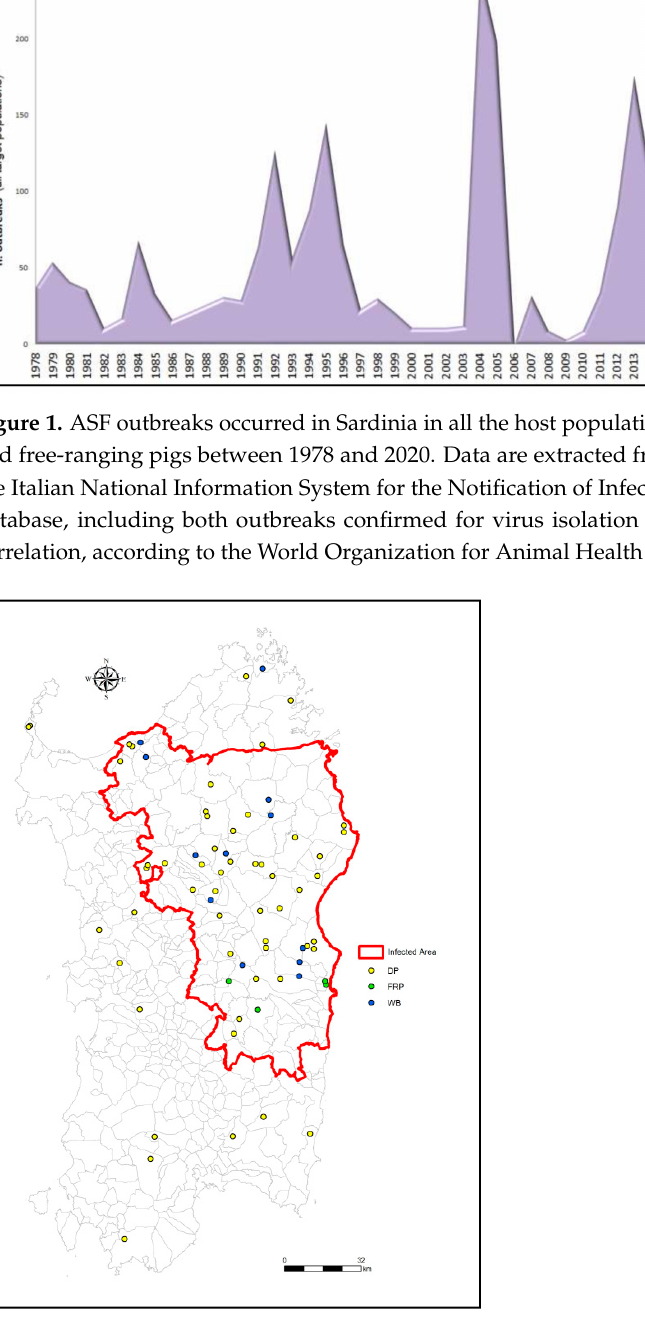
Figure 2. Spatial distribution of the 71 sampling sites in Sardinia. The yellow dots refer to domestic pig (DP) samples, the blue dots indicate wild boar (WB) samples, and green refer to illegal free- ranging pigs (FRP). The red line defines the limits of the historic wild boar infected area. The map reports both the 58 new and the 13 previously sequenced samples.